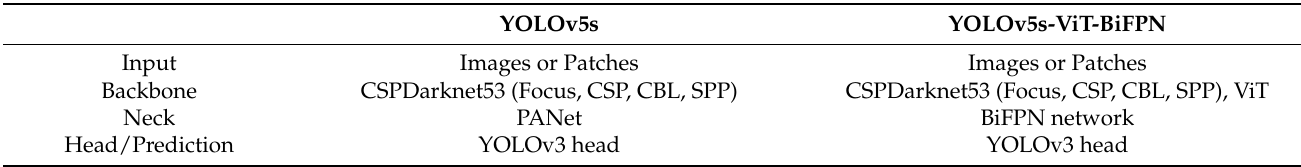
Table 2. Comparison of the structures of YOLOv5s and YOLOv5s-ViT-BiFPN. YOLOv5s YOLOv5s-ViT-BiFPN Input Images or Patches Images or Patches Backbone CSPDarknet53 (Focus, CSP, CBL, SPP) CSPDarknet53 (Focus, CSP, CBL, SPP), ViT PANet BiFPN